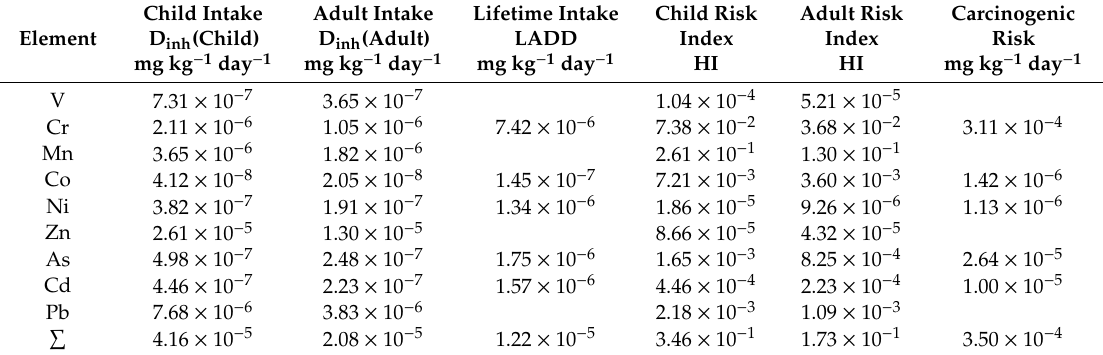
Table 4. Annual heavy metal inhalation exposure concentrations and health risks.